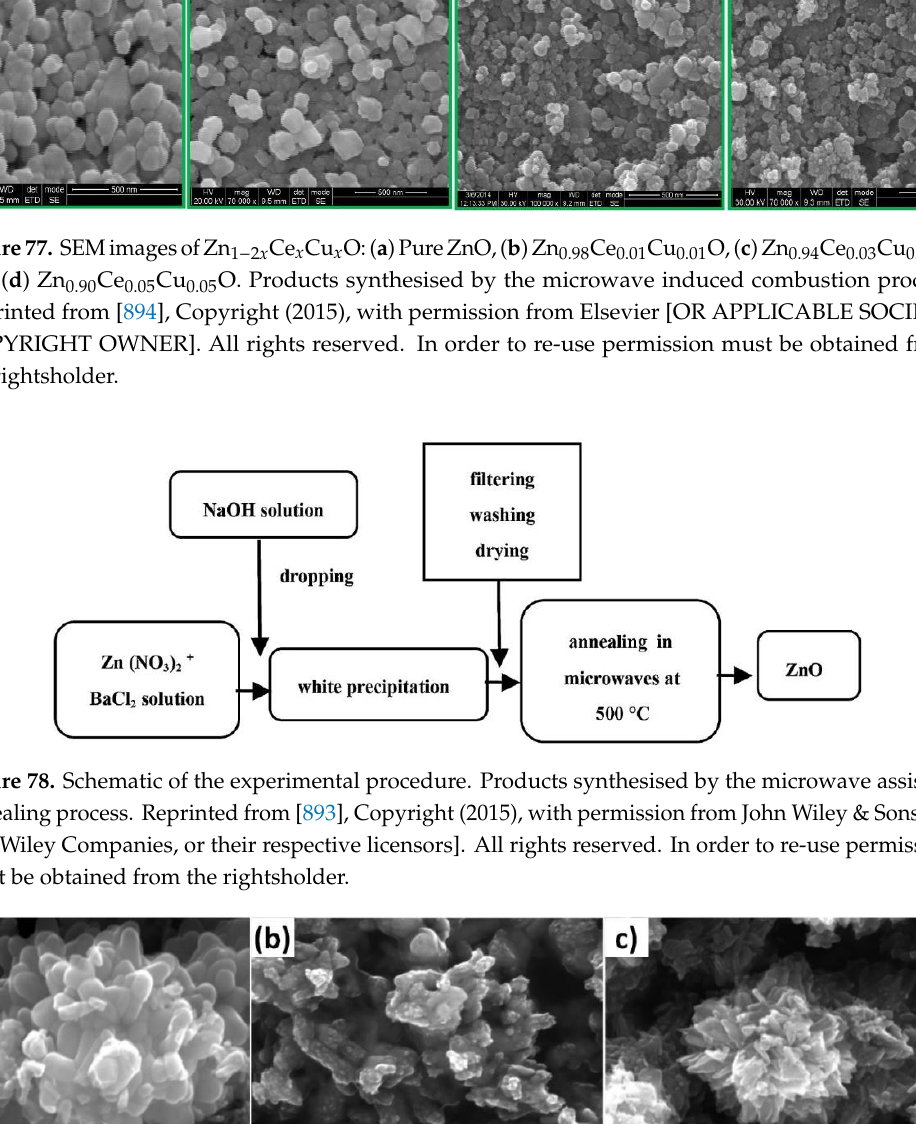
Figure 77. SEM images of Zn 1−2 x Ce x Cu x O: ( a ) Pure ZnO, ( b ) Zn 0.98 Ce 0.01 Cu 0.01 O, ( c ) Zn 0.94 Ce 0.03 Cu 0.03 O and ( d ) Zn 0.90 Ce 0.05 Cu 0.05 O. Products synthesised by the microwave induced combustion process.